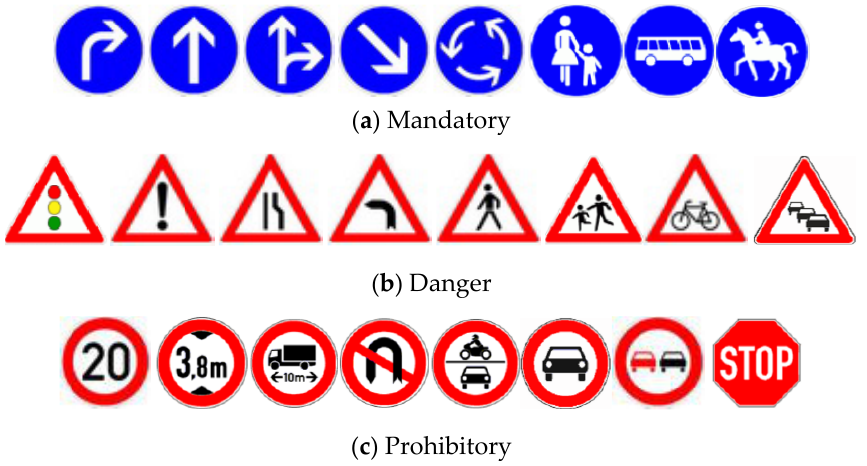
Figure 2. Samples of the three super categories in Germany.